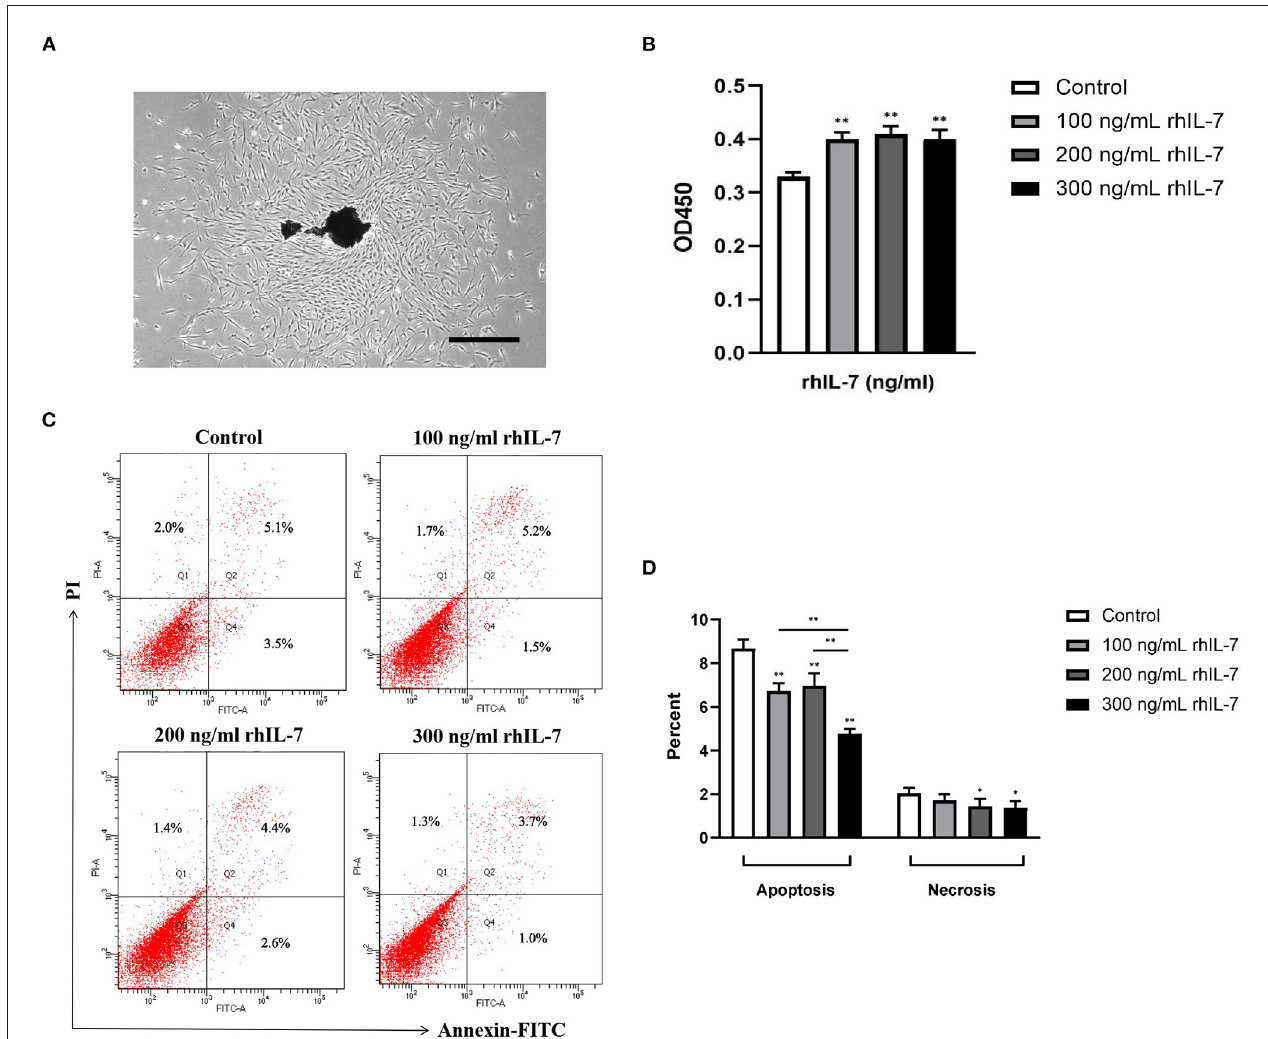
FIGURE 2 | Primary human periodontal ligament cells. (A) Under the microscope, it can be seen that many fibroblast cells are crawling out around the dark brown primary tissue block. The cells are adherent to the wall and grow with a clear outline. Most of the cells are flat and spindle-shaped or star-shaped structures arranged in radial or whirlpool shape. Effect of rhIL-7 on the proliferation of hPDLCs. Scale bar = 1,000 µ m. (B) After hPDLCs were treated with different concentrations of rhIL-7 for 24h, CCK-8 was used to detect the cell survival rate of the hPDLCs. A summary of the results is shown in the bar graphs. Effect of rhIL-7 on the apoptosis and necrosis of hPDLCs. (C,D) We used Annexin V-FITC/PI staining to detect the proportion of apoptosis and necrosis in the cells of each group by FCM. Representative dot plots show the gating strategy of FCM analysis. The number in the scatter plot represents the percentage of cells in the corresponding state. n